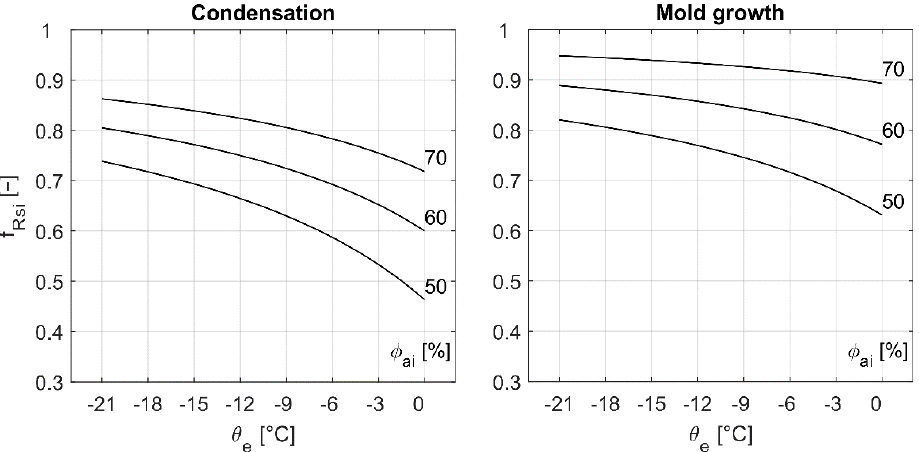
Figure 4. Minimum values of the surface temperature factor to avoid water vapor condensation ( left ) and mold growth ( right ) assuming an interior air temperature of 20 °C for different air humidity.